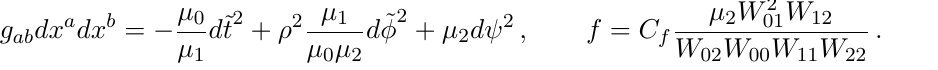
S 2 . ( b ) By sending the rod endpoint w ×